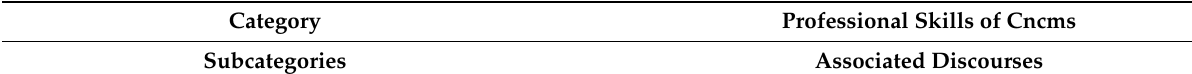
Table 3. Category P: Professional skills of CNCMs.